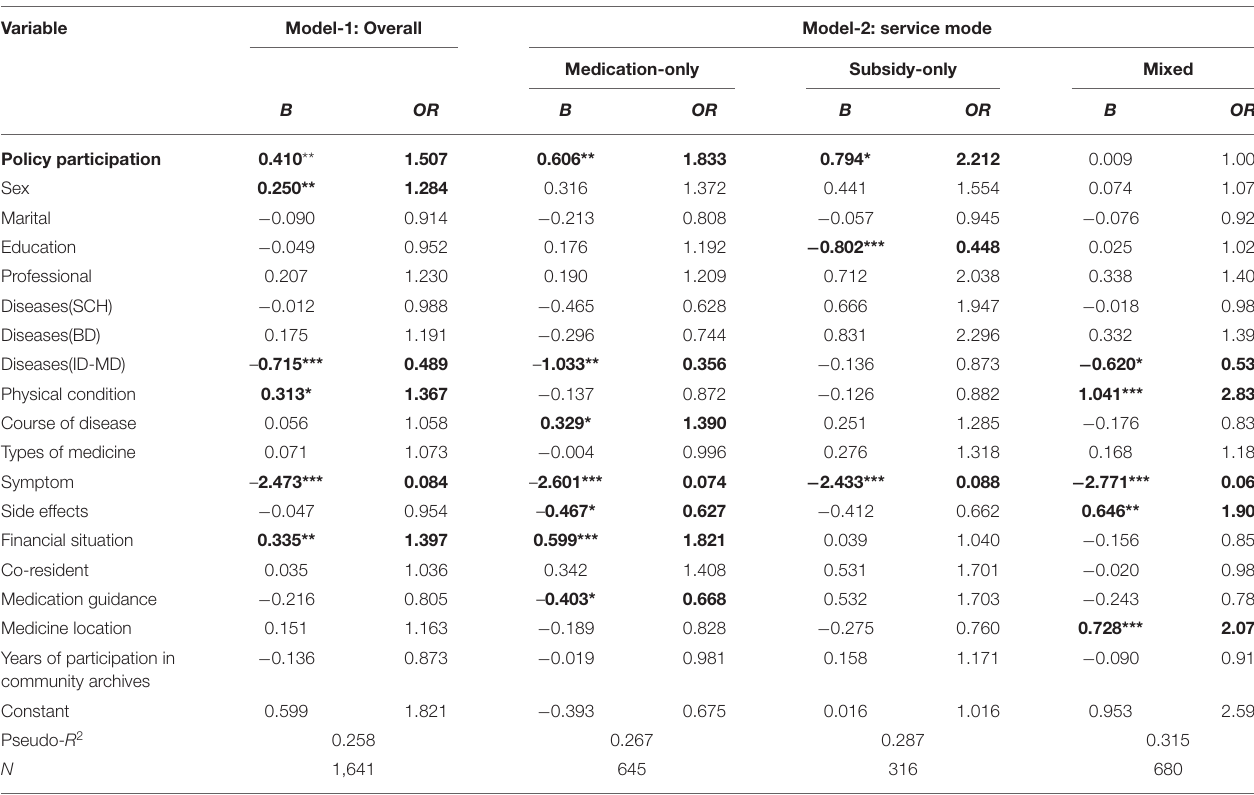
TABLE 3 | Logistic regression model